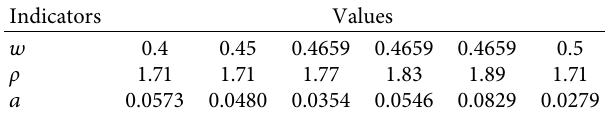
Table 5: The test values of w ρ , and a .